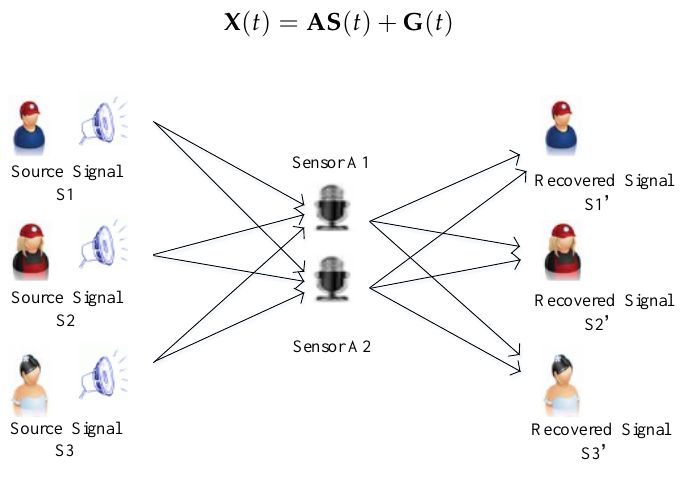
Figure 8. Schematic diagram of cocktail reception signal mixing.